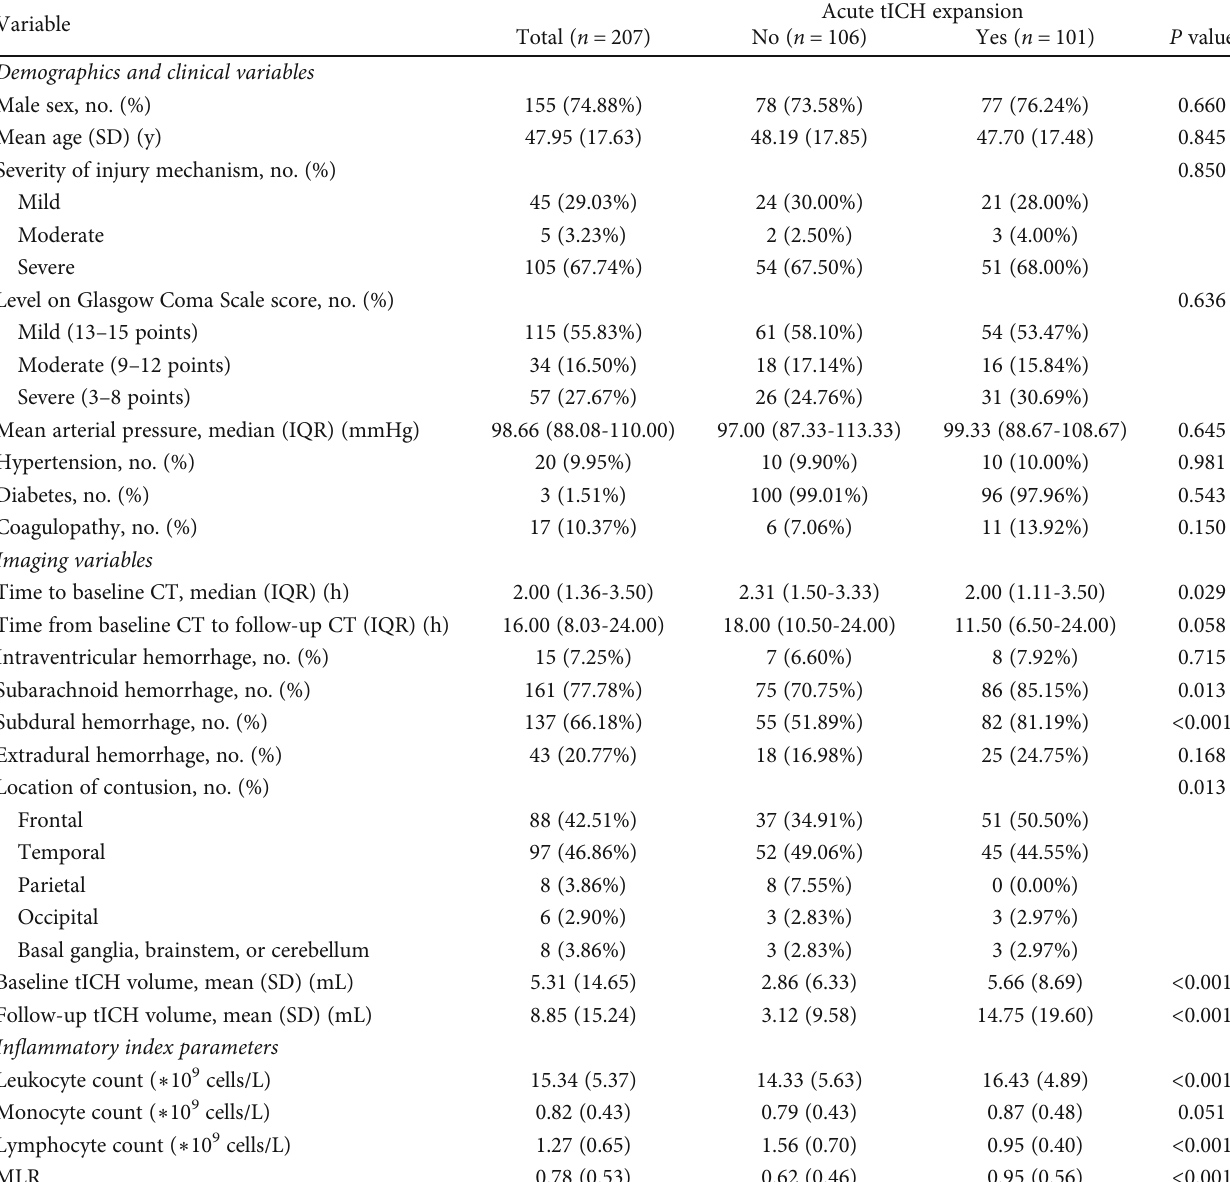
Table 3: Baseline characteristics according to acute tICH expansion in the validation